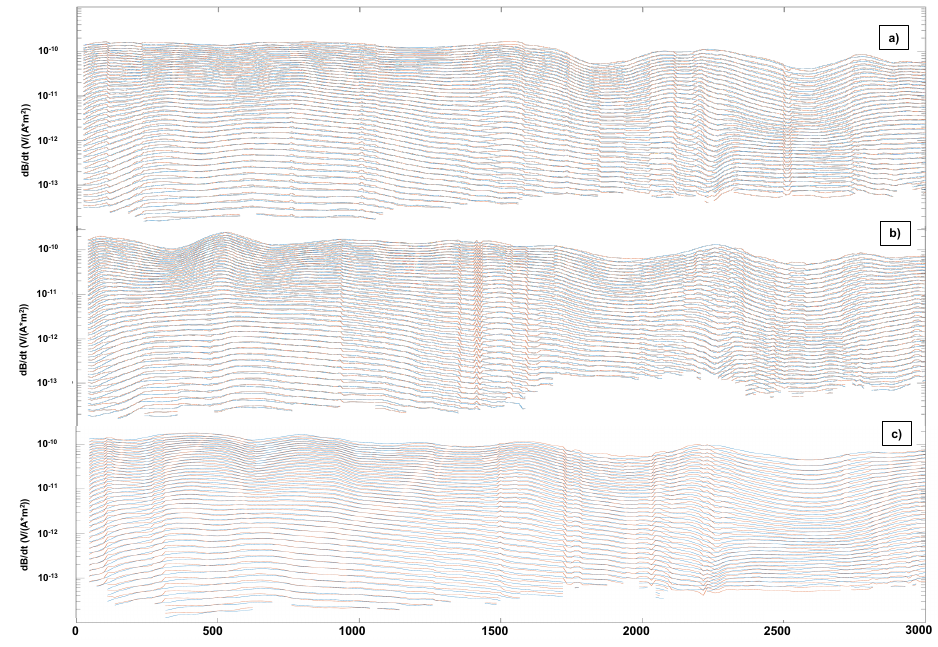
Figure 5. Comparison between the synthetic data from the true model in Figure 2 (blue lines) and the calculated data from the conductivity sections retrieved by the ANN in Figure 3 (red lines). The data in the panels ( a – c ) in the present figure correspond to the conductivity sections shown in the three panels in each of the Figures 2 and